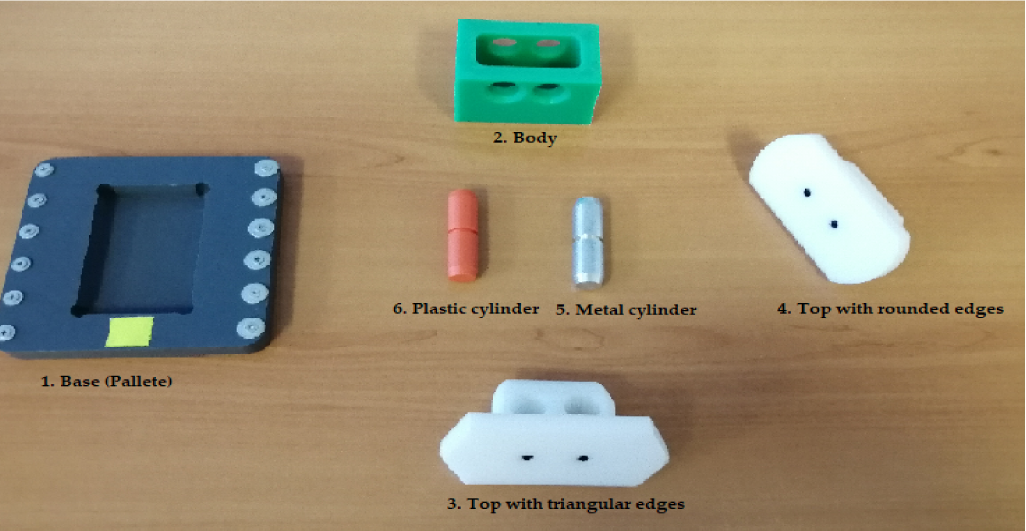
Figure 6. Workpiece parts.